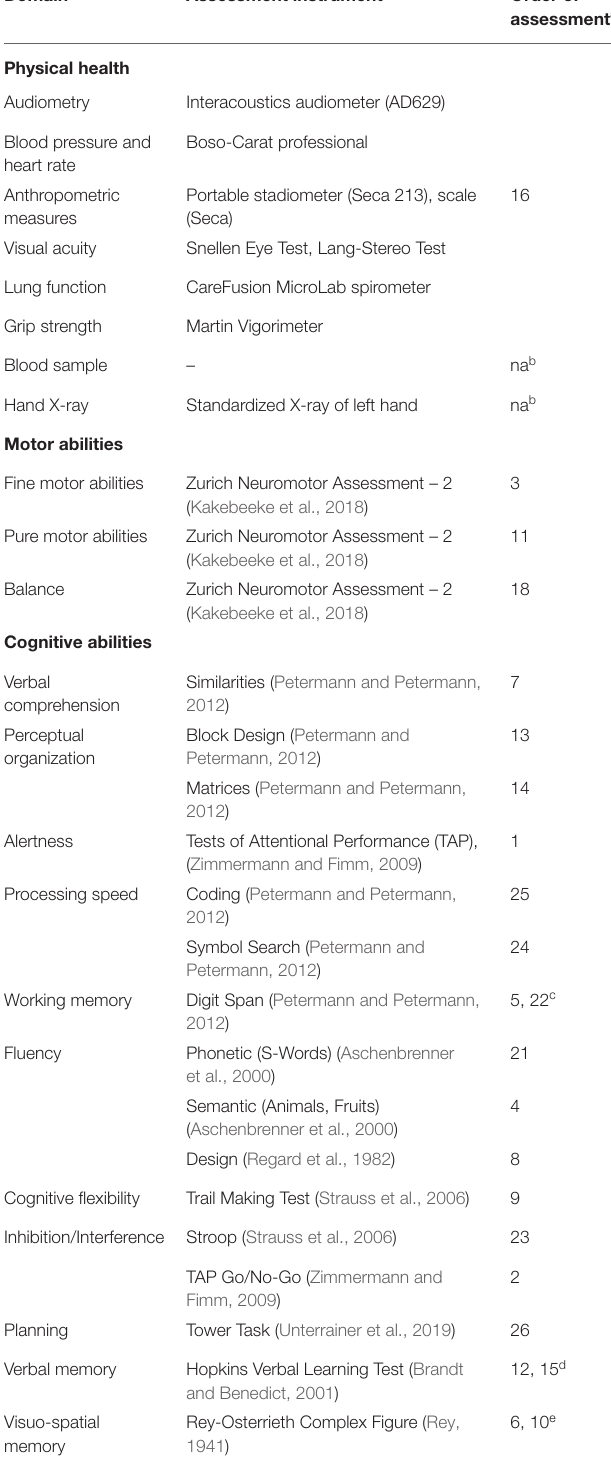
TABLE 2 | Test battery of onsite assessment for the first wave of ZLS-Adulthood (grouped by domain).